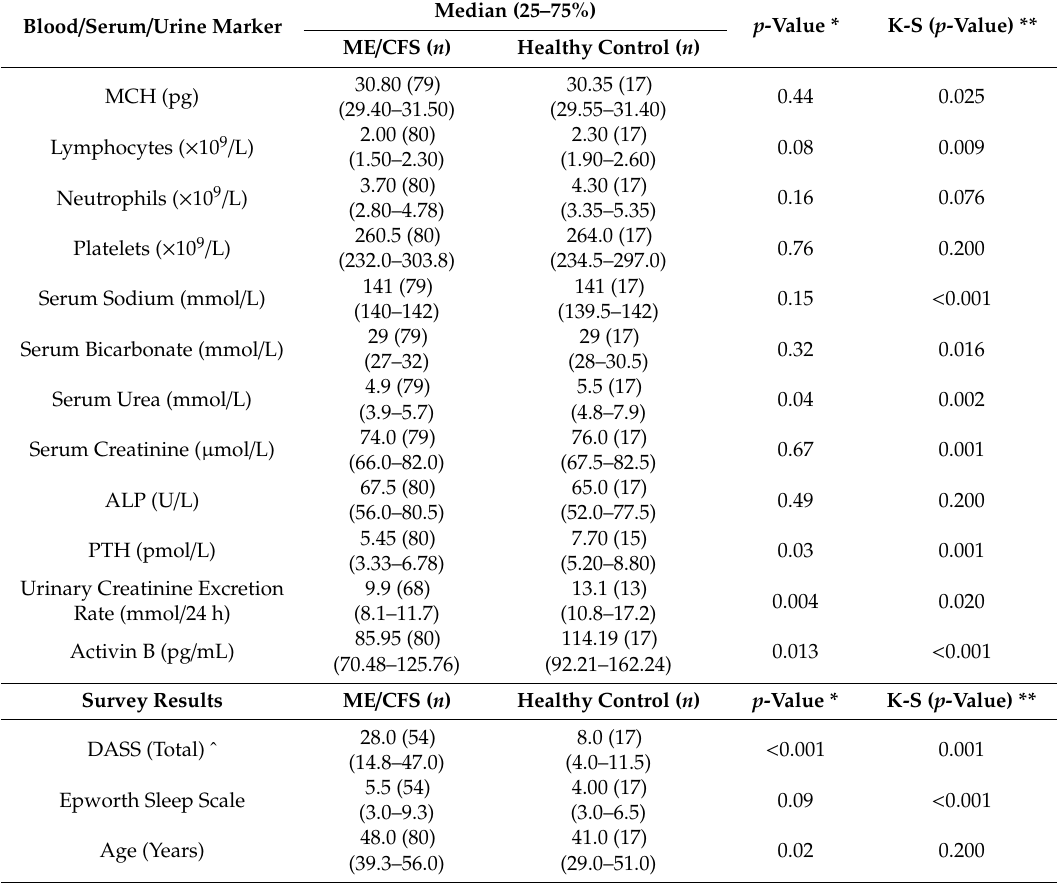
Table 2. Comparison of ME / CFS and healthy control participants via a range of pathology